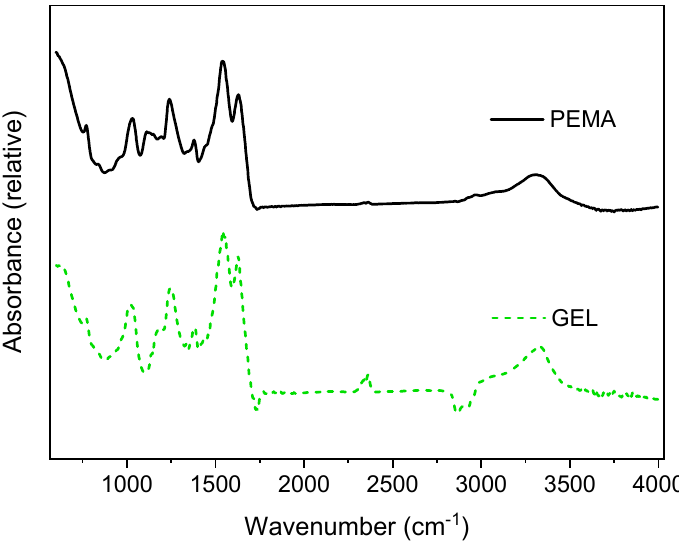
Figure 2. FTIR analysis for the PUF resin produced with PEMA and GEL emulsifiers.